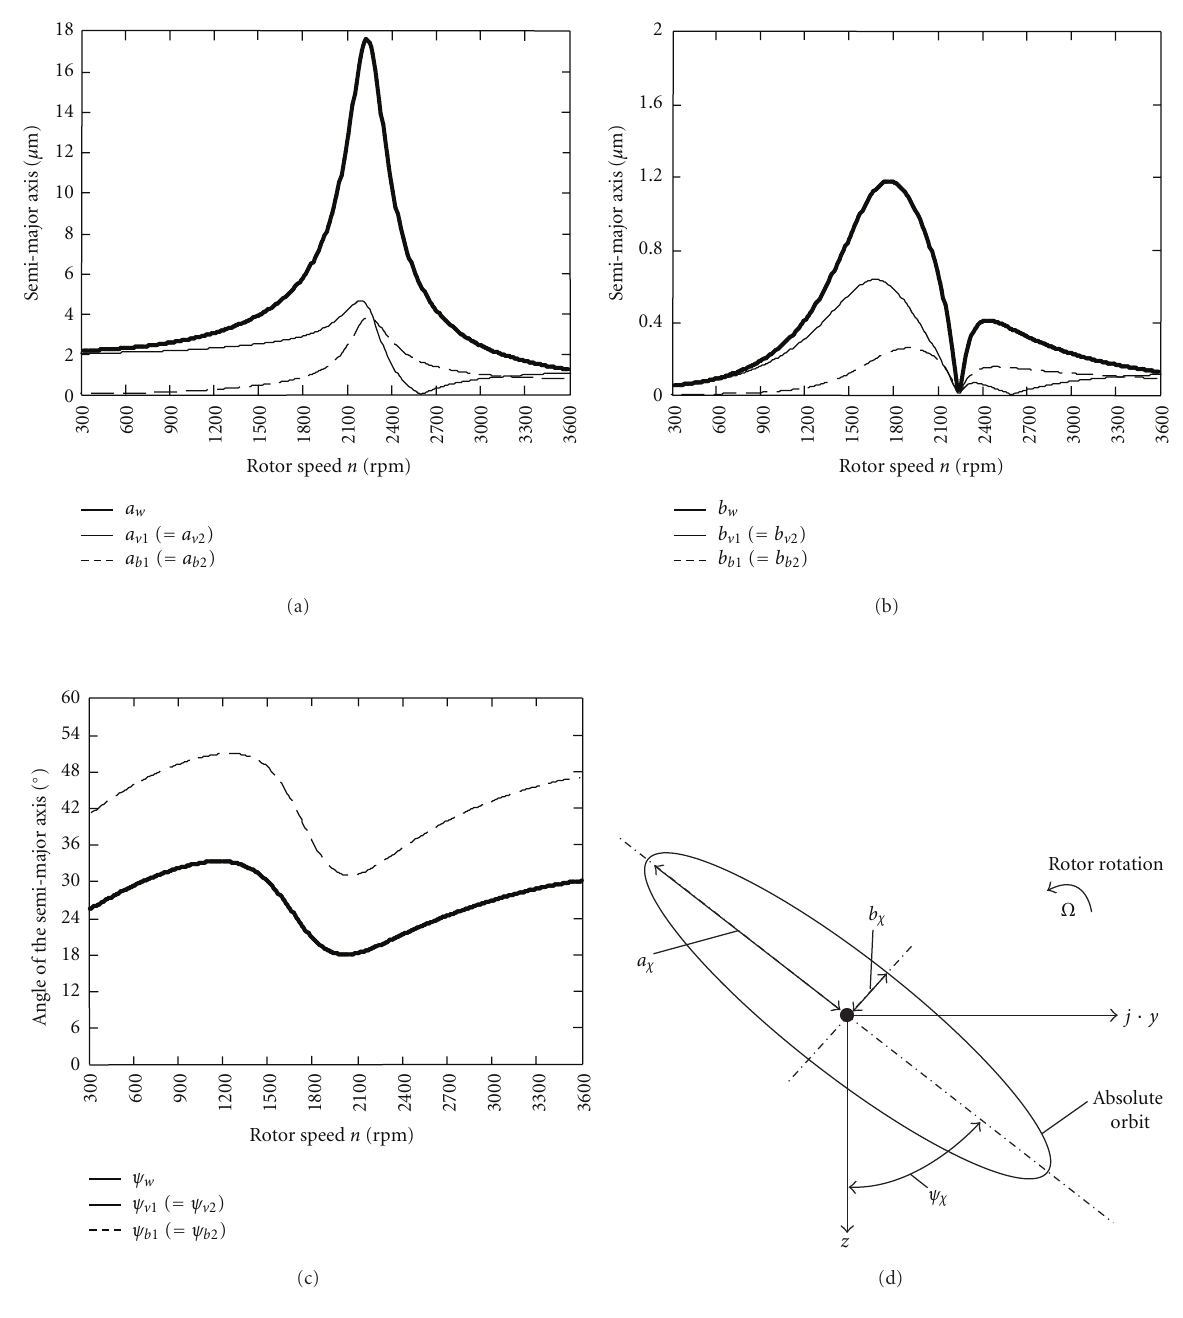
Figure 9: Absolute orbits of the shaft centre point W , of the shaft journal points V 1 and V 2 and of the bearing housing points B 1 and B 2 , described by (a) the semi-major axes, (b) the semi-minor axes, and (c) the angles of the semi-major axes. (d) Definition of the absolute orbits. Boundary condition: identical orientation of the elliptical shaft journals ( ϕ 1 = ϕ 2 ) and di ff erent rotor speeds.